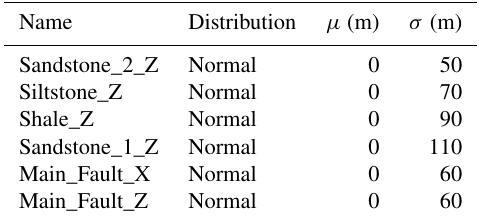
Table 1. Distribution parameters for prior parameterization of the synthetic fault